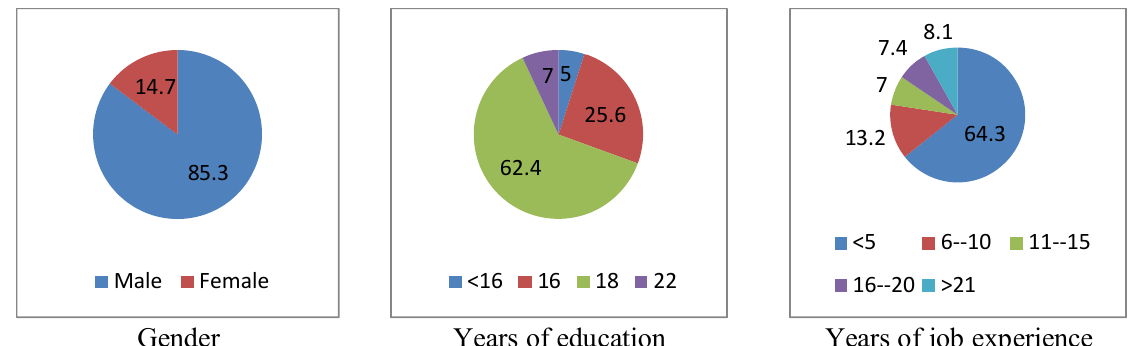
Fig. 1. Personal characteristics of the